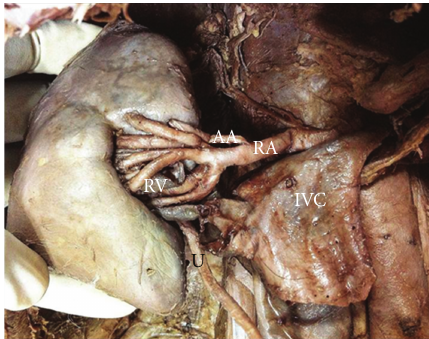
Figure 2: Right kidney: showing congested hilum due to multiple branching pattern of renal artery (RA). AA: aberrant artery, RV: renal vein, IVC: inferior vena cava, and U: ureter.